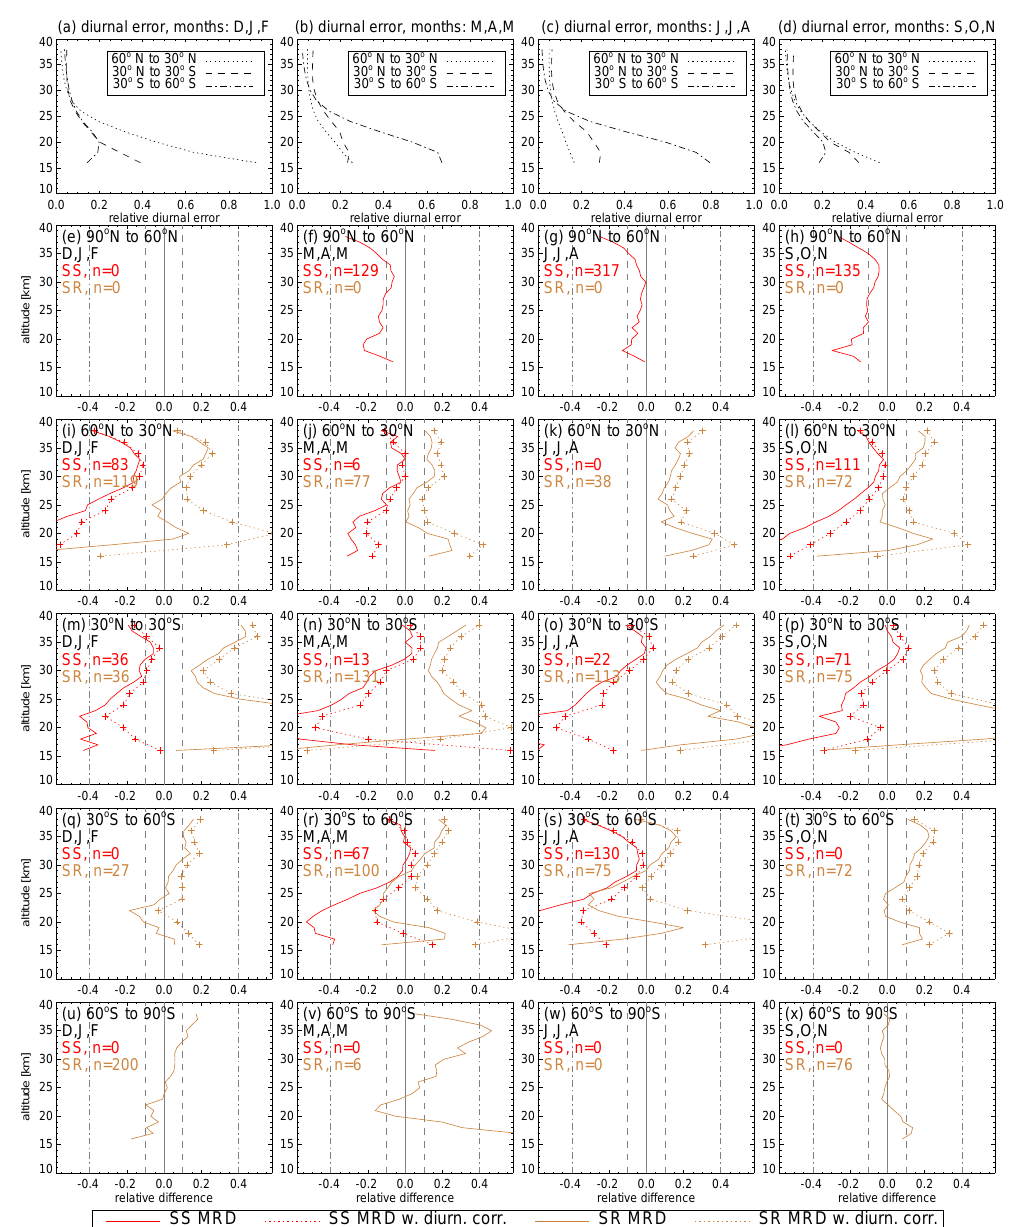
Fig. 10. Panels (a) to (d) : relative diurnal effect errors for the SAGE II profiles shown in Fig. 9. A model was used to estimate the diurnal effect error for each SAGE II occultation. These represent the mean errors over the latitude/seasonal bin. The influence of this error on the agreement between the SAGE II and SCIAMACHY is estimated in panels (i) to (t) for each latitude and season. MRDs with photochemical corrections and without diurnal effect error correction are displayed as red (sunset) and orange (sunrise) solid lines. MRDs with consideration of the diurnal effect error are given as dashed lines with the same color-coding.